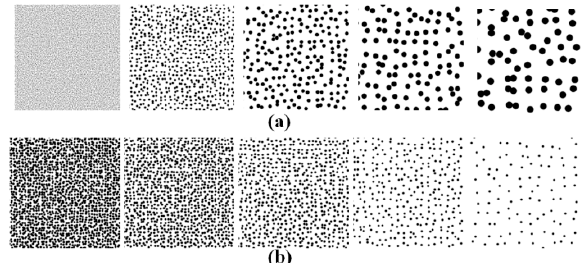
Figure 2. Simulated speckle patterns with ( a ) different speckle sizes and ( b ) different speckle den- sities.